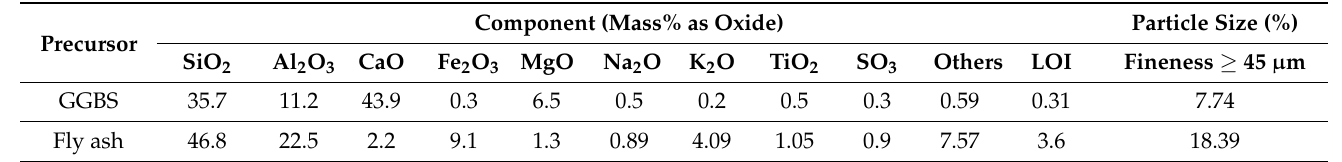
Table 2. Oxide compositions and particle size of GGBS and fly ash.